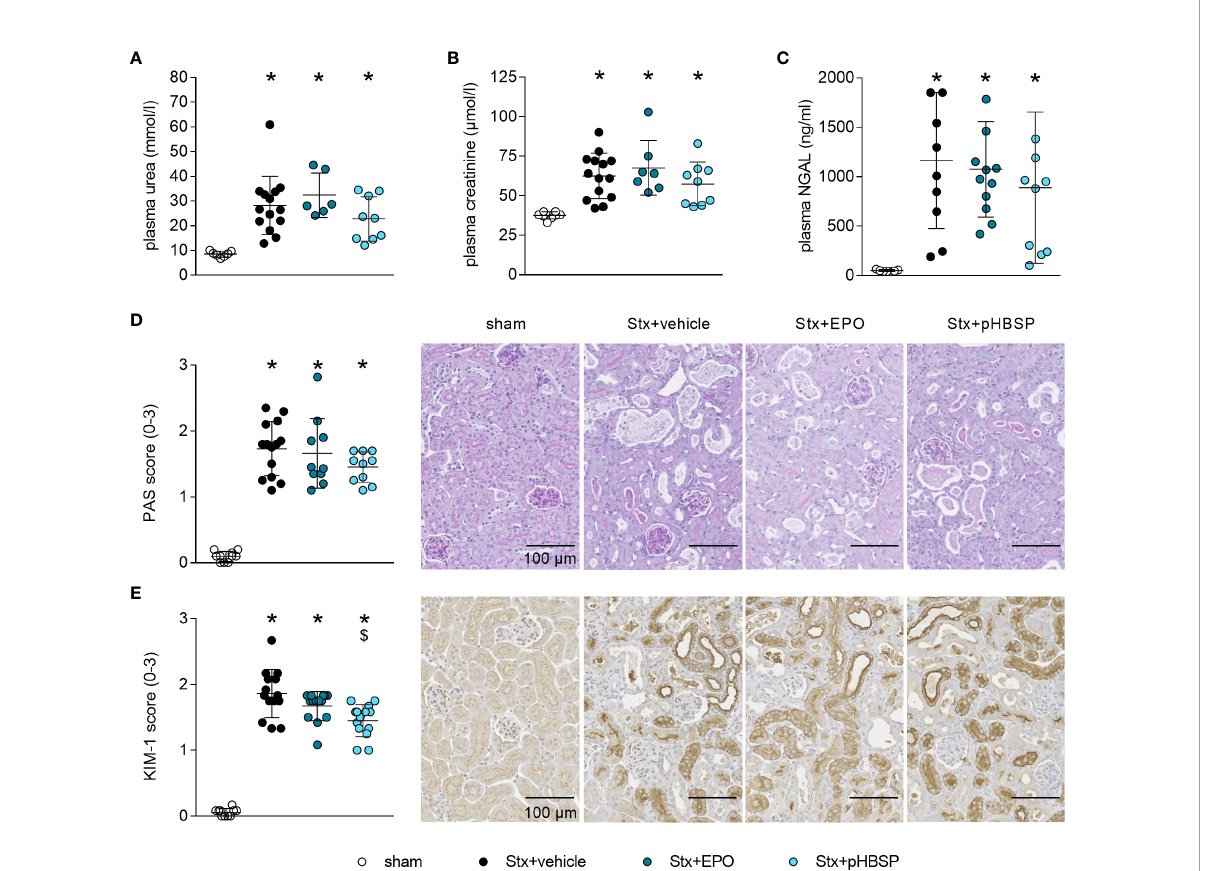
FIGURE 4 Effect of EPO and pHBSP treatment on kidney dysfunction and tubular injury in mice with HUS. Kidney injury and dysfunction was assessed on day 7 of HUS experiment. Plasma samples of mice with HUS and sham mice were analyzed for the kidney dysfunction parameters (A) urea and (B) creatinine (sham n = 7, Stx+vehicle n = 14, Stx+EPO n = 6, Stx+pHBSP n = 9) by an Architect ™ ci16200 System (Abbott), as well as the kidney injury marker (C) NGAL (sham n = 7, Stx+vehicle n = 10, Stx+EPO n = 12, Stx+pHBSP n = 10) by ELISA. (A-C) Data are expressed as scatter dot plot with mean ± SD. *P < 0.05 vs. sham (one-way ANOVA, Holm-Sidak ’ s multiple comparison test). Quanti fi cation data as well as representative images (scale bar 100 µm) of (D) PAS staining (sham n = 10, Stx+vehicle n = 14, Stx+EPO n = 10, Stx+pHBSP n = 10, 10 fi elds per slide, score 0: no damage, 1: < 25% damaged, 2: 25 – 50% damaged, 3: > 50% damaged) and (E) immunohistochemical KIM-1 staining (score 0: < 25%, 1: 25 – 50%, 2: 50 – 75%, 3: > 75% strong positive staining per visual fi eld, sham n = 10, Stx+vehicle n = 14, Stx+EPO n = 14, Stx+pHBSP n = 14, 12 fi elds per slide) in renal sections of sham and Stx-challenged mice. (D, E) Data are expressed as scatter dot plot with mean ± SD. *P < 0.05 vs. sham, $ P < 0.05 vs. Stx+vehicle, (Kruskal-Wallis test, Dunn ’ s multiple comparison